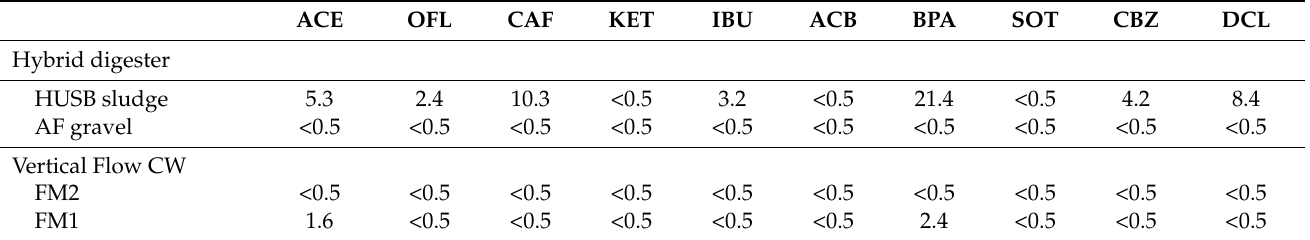
Table 5. Concentrations of EPs in the solid phases of the HD and VF treatment